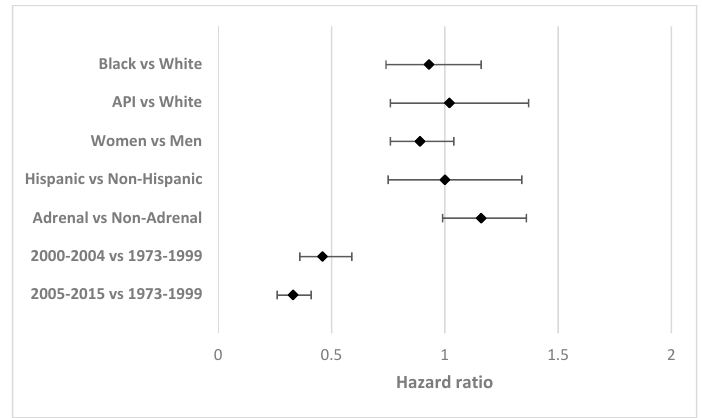
Figure 2. Forest plot of the adjusted hazard ratios of race, ethnicity, sex, type of cancer, and year of diagnosis for 5-year cause-specific survival among patients in the SEER database diagnosed with neuroblastoma between 1973 and 2015.